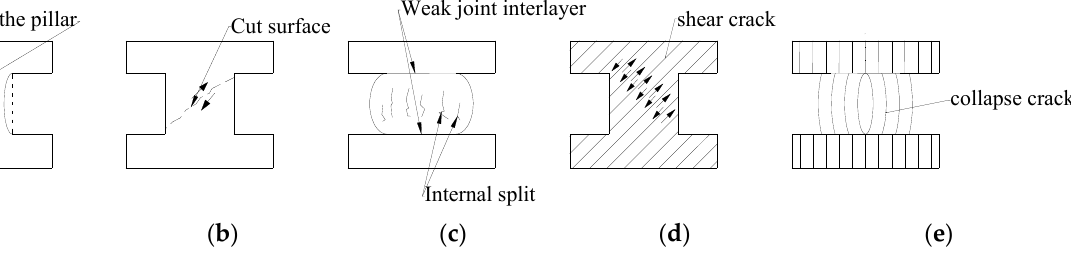
Figure 3. Salt pillar destruction form. ( a ) Tension Failure; ( b ) Shear Failure; ( c ) Swelling Failure; ( d ) Slip Failure; ( e ) Collapse Failure.